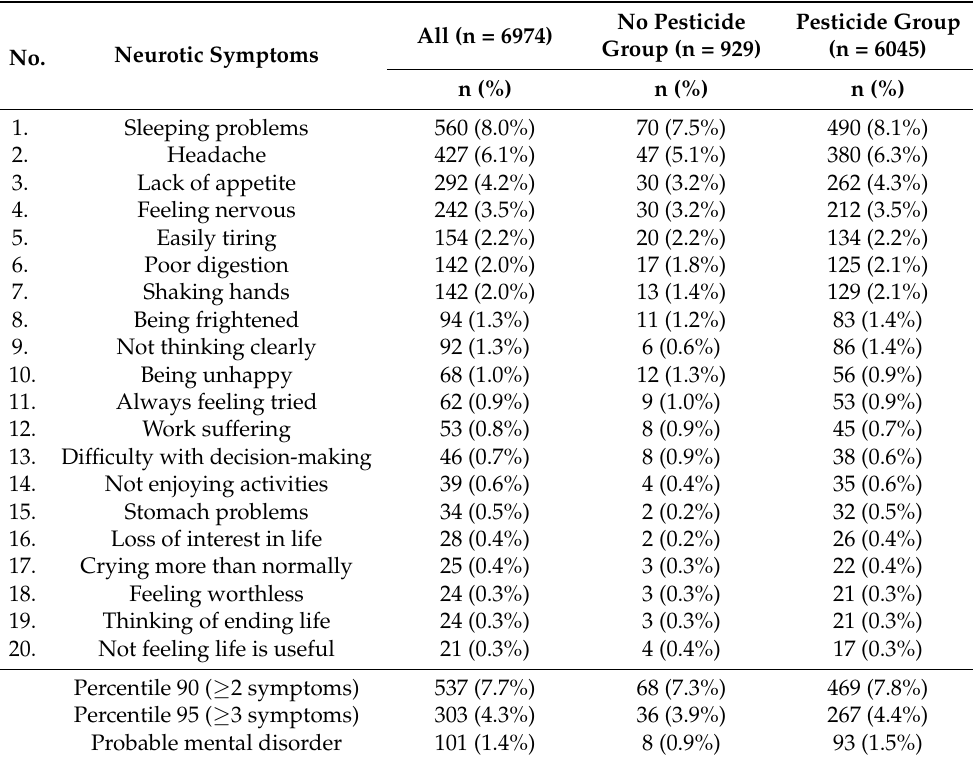
Table 3. Prevalence of neurotic symptoms and mental disorder from the Self-Reporting Questionnaire (SRQ-20) in Thai farmers.